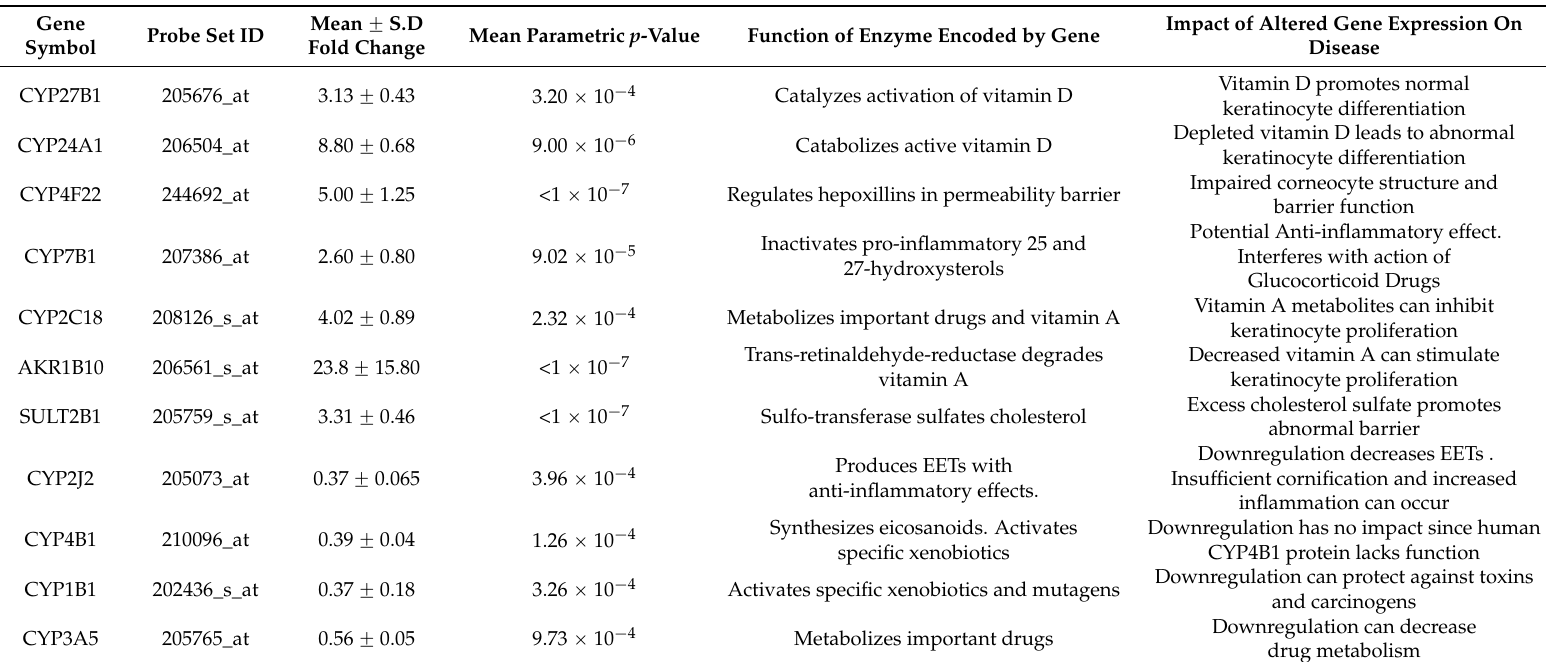
Table 2. Differentially-expressed genes in plaque psoriatic skin versus normal skin. Mean fold change and p -values for each gene were calculated from three of the four datasets. The first seven genes were 3-25-fold upregulated in psoriasis. The last four genes were 1.80–2.50 fold downregulated in